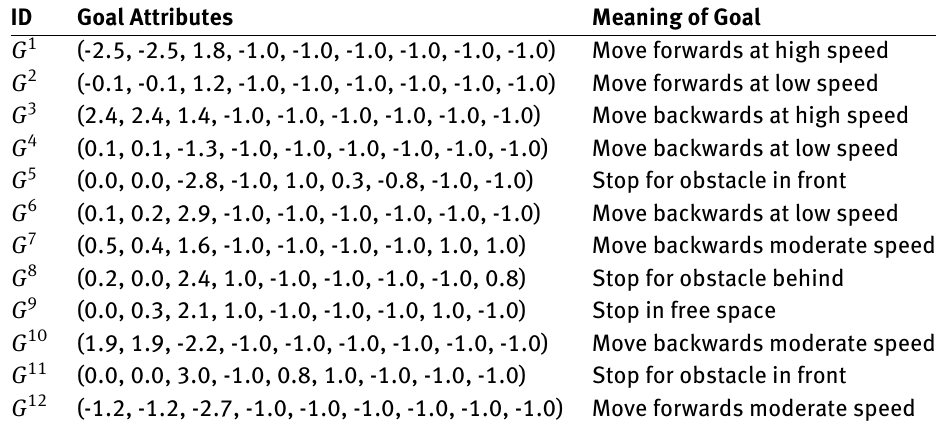
Table 2: Maintenance goal prototypes generated in the first run of experiment 1 with ρ M = 0.9. Weights are rounded to 1 decimal place.